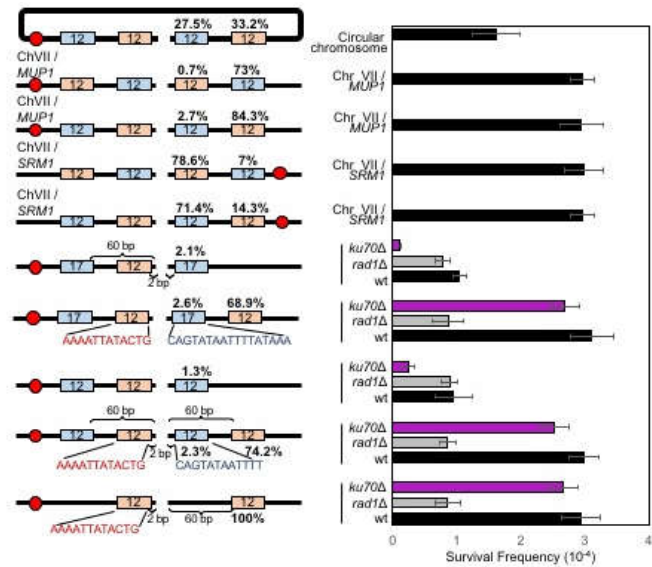
Figure 5. The position effect of microhomology on MMEJ. (A) Left: A diagram of MMEJ reporters with microhomology pairs at different locations to the HO break. The locations of HO cut site (arrow), microhomology (orange and blue boxes), and centromere (red circles) are shown. The size of microhomology is shown in number (bp) inside the microhomology. The distance to the break (bp) is shown above each microhomology. The size of the 3 (cid:48) flap (bp) and the sequences of microhomologies are also shown. Percentage of repair event was calculated by dividing the number of repair events using each microhomology with the number of all repair events, regardless of the repair types and shown above each microhomology. The repair events were analyzed by sequencing of the repair junctions from > 100 Ura- survivors. Right: Graph showing survival frequency ± s.d. in wild type (WT), RAD1 ∆ (MMEJ deficient mutant), and ku70 ∆ (C-NHEJ deficient mutant). Survival frequency was calculated as described in Figure 1. The results are the average of three independent